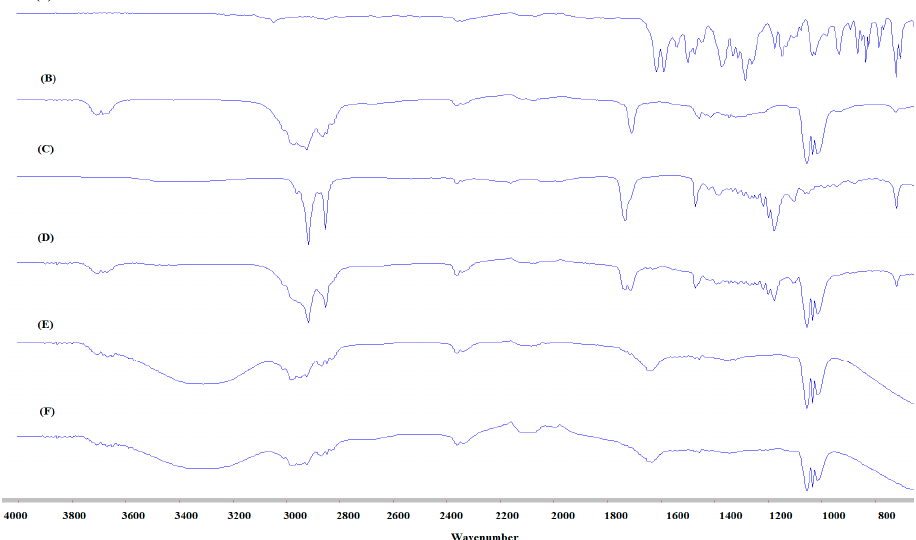
Figure 2. Stability of optimized CIP-NLC-IG formulation stored at 4 ± 2 ◦ C and 25 ± 2 ◦ C over one month—( A ) drug content and ( B ) viscosity (mean ± SD, n = 3).